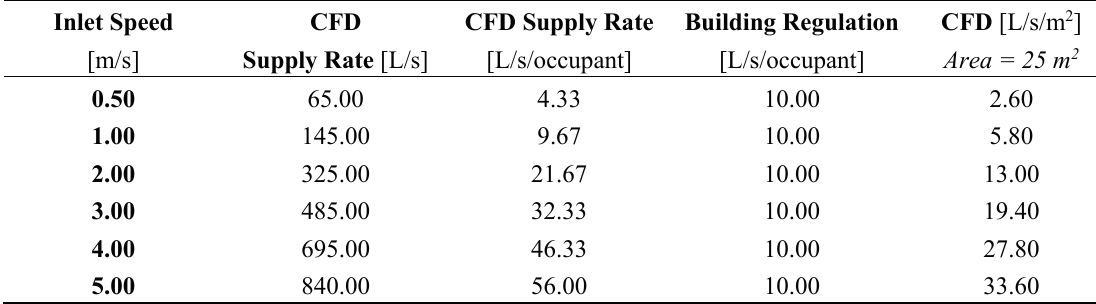
Table 1. Summary of the supply rates of the wind tower with heat transfer device.